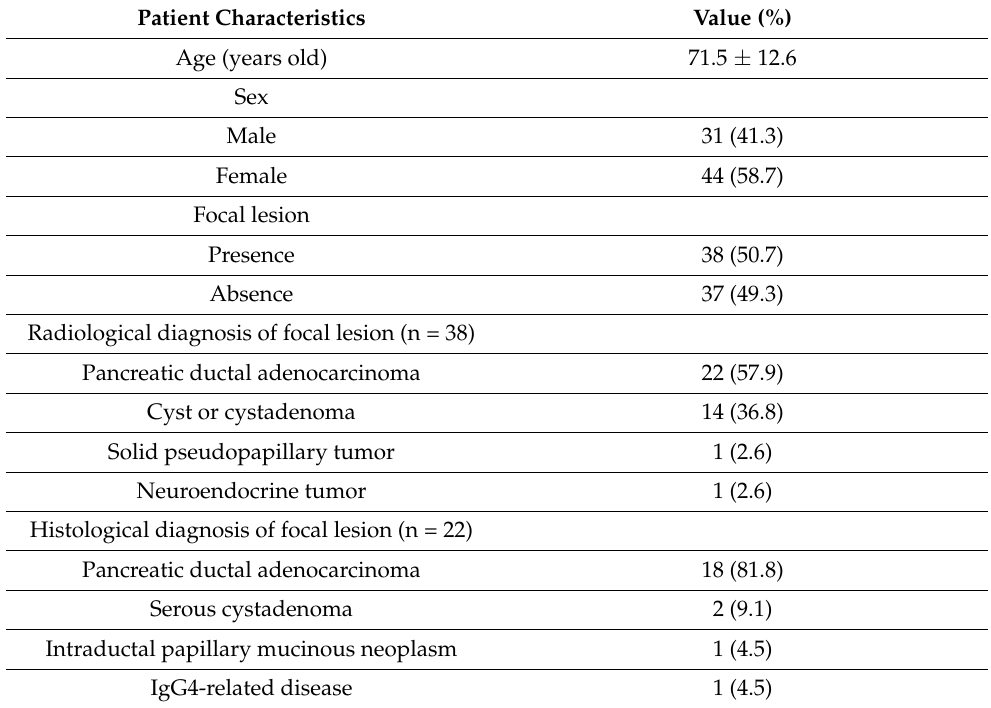
Table 2. Characteristics of